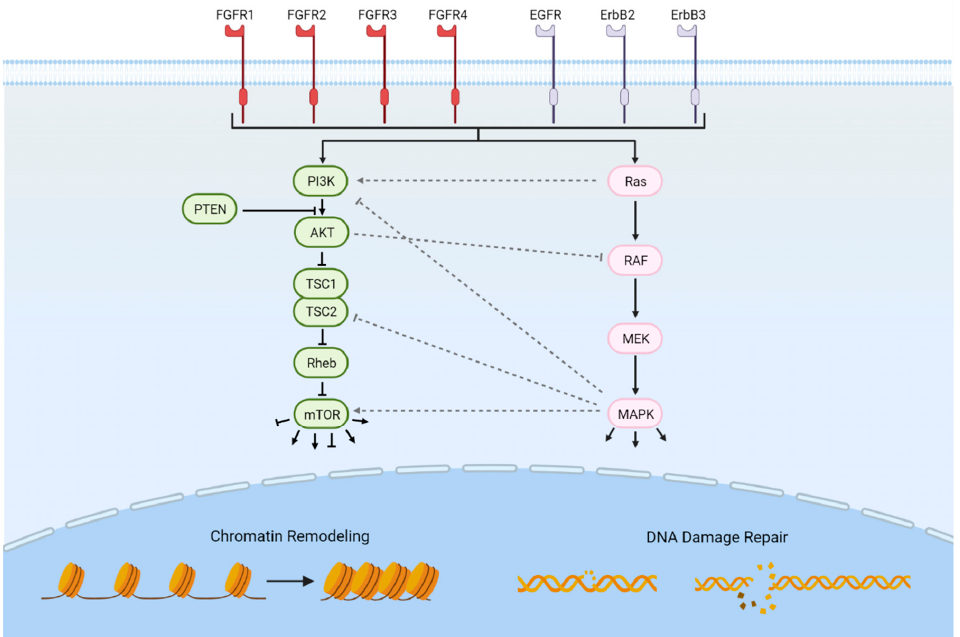
Figure 1. Potentially targetable genetically altered pathways in advanced bladder cancer. Frequently mutated pathways in advanced bladder cancer include RTKs such as the FGFRs and ErbB receptor groups. Intracellular pathways include the PI3K/Akt/mTOR pathway, the RAS-MAPK signaling pathway, chromatin remodeling, and DNA damage repair. Significant cross-talk exists between the PI3K/Akt/mTOR and RAS-MAPK pathways. Downstream effects of mTOR activation include cell cycle progression and cellular growth; downstream effects of MAPK activation include the regulation of translation, differentiation, and the cell cycle. Figure created with biorender.com (accessed on 22 February